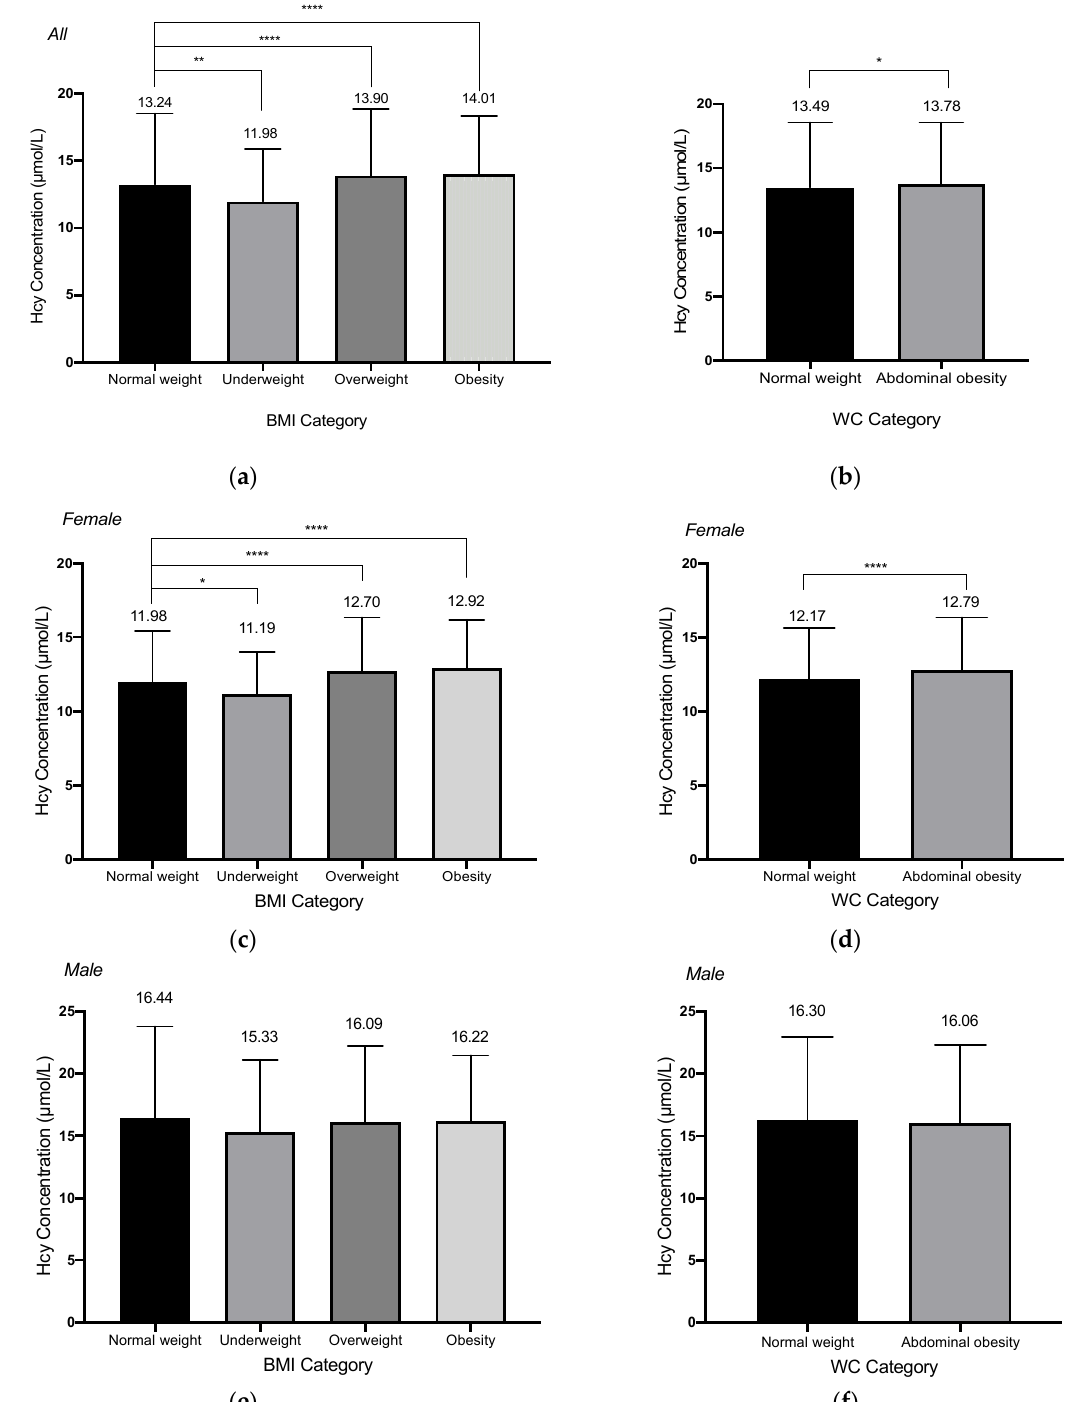
Figure 3. The homocysteine concentrations categorizing by body mass index (BMI) or waist circumference (WC) for all subjects ( a , b ), female subject ( c , d ) and male subjects ( e , f ). For BMI categories, subjects were categorized into four categories (underweight: <18.5 kg/m 2 ; normal weight: 18.5–23.9 kg/m 2 ; overweight: 24.0–27.9 kg/m 2 ; obesity: ≥ 28.0 kg/m 2 ); for WC categories, subjects were categorized into two categories (Normal weight: < 85.0 cm for female, <90.0 cm for male; abdominal obesity: ≥ 85.0 cm for female, ≥ 90.0 for male). * 0.01 < p < 0.05; ** 0.001< p < 0.01; **** p < 0.0001.